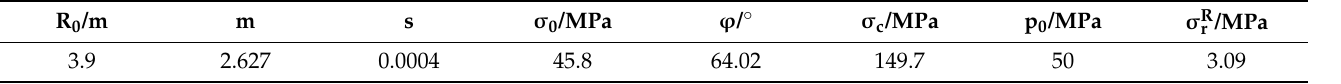
Table 8. Calculation parameters of the plastic region radius of the lining